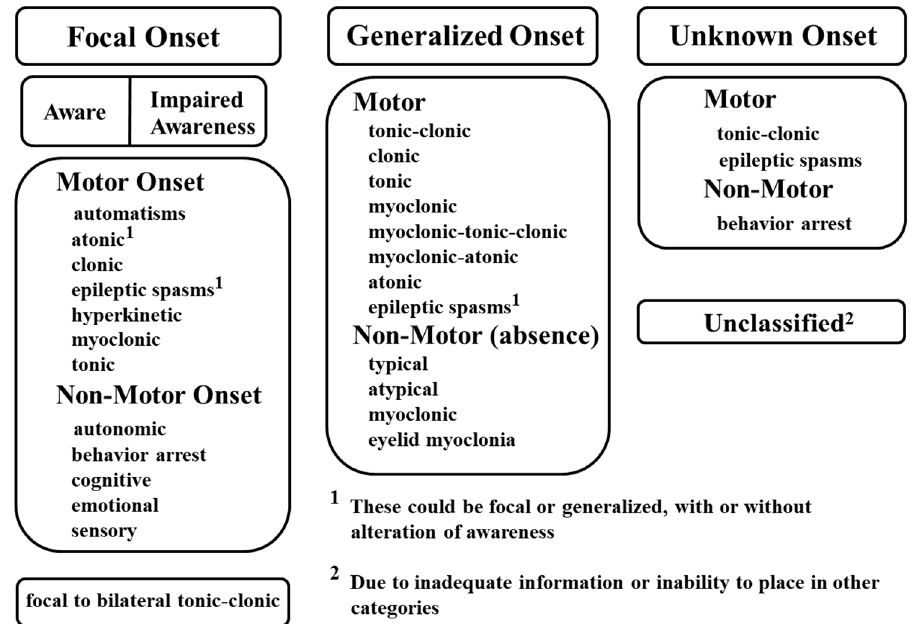
Figure 1. International League Against Epilepsy (ILAE) guidelines for the classification of seizure types. Reprinted with permission from Wiley [23].